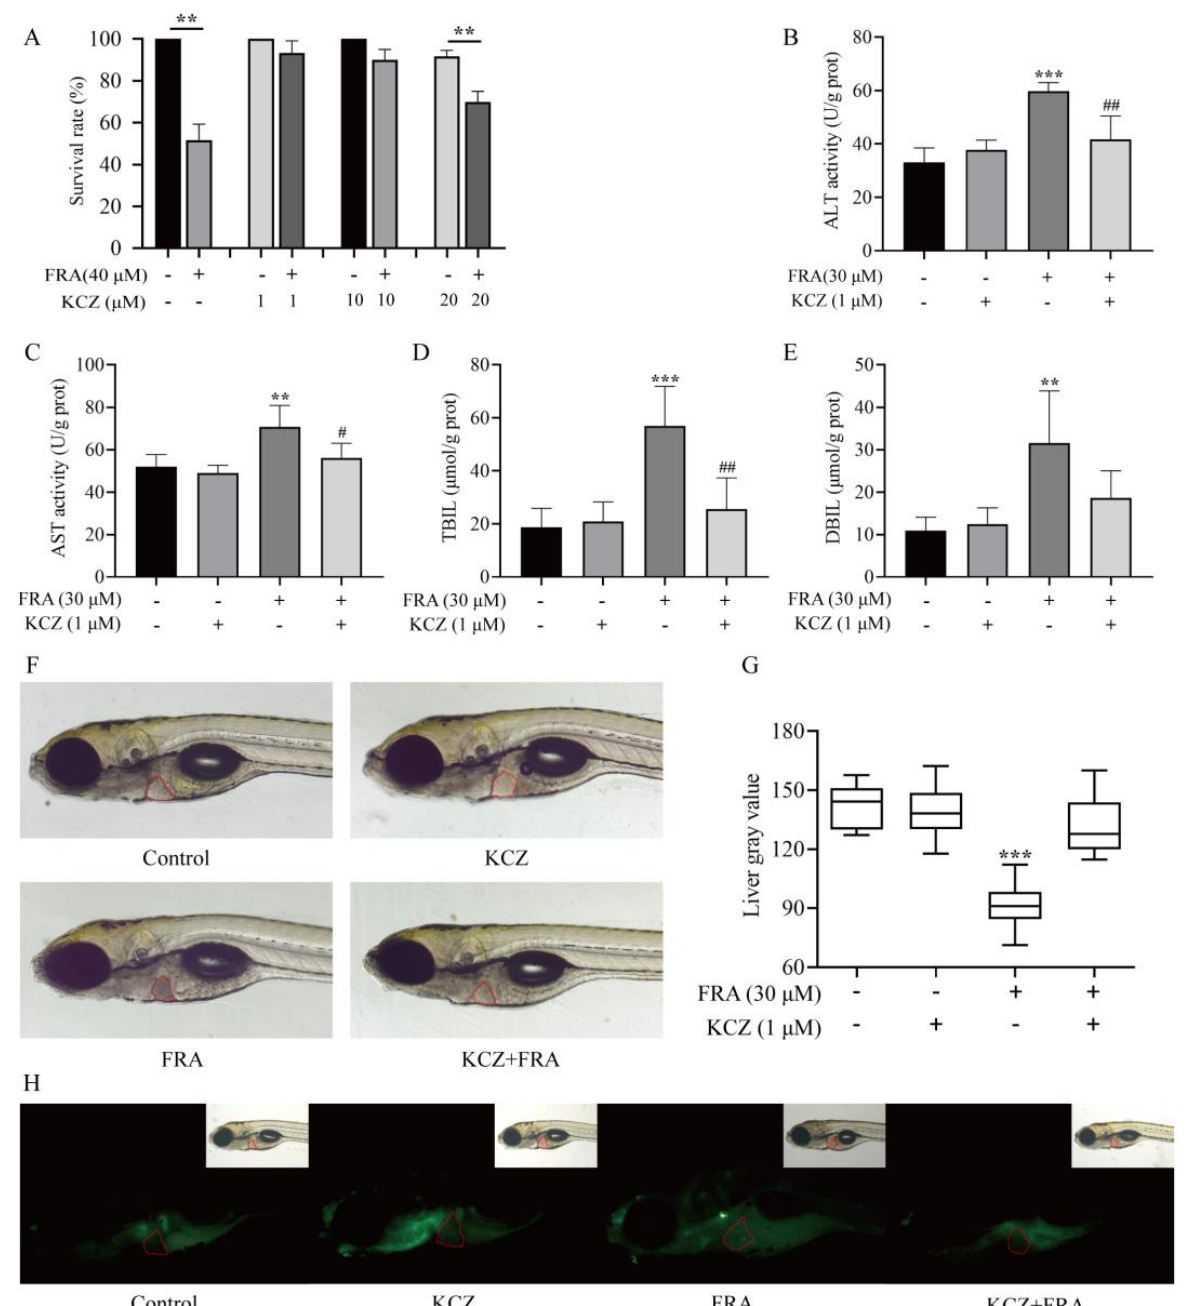
Figure 6. Inhibitory effects of KCZ against FRA-induced hepatotoxicity. ( A ) KCZ reduced FRA-induced mortality of zebrafish larvae. The biochemical indices of ALT ( B ), AST ( C ), TBIL ( D ), and DBIL ( E ) decreased significantly after KCZ treatment. ( F – H ) Morphological observation and AO staining to determine the degree of liver injury and apoptosis. Data are presented as the mean ± SD. Each experiment was performed 3 times with 40 randomly selected zebrafish larvae. ** p < 0.01 vs. control; *** p < 0.001 vs. control; # p < 0.05 vs. FRA + KCZ; ## p < 0.01 vs. FRA+KCZ. 2.7. KCZ Altered the Expression Patterns of Transporter and Apoptotic Proteins Inhibited by